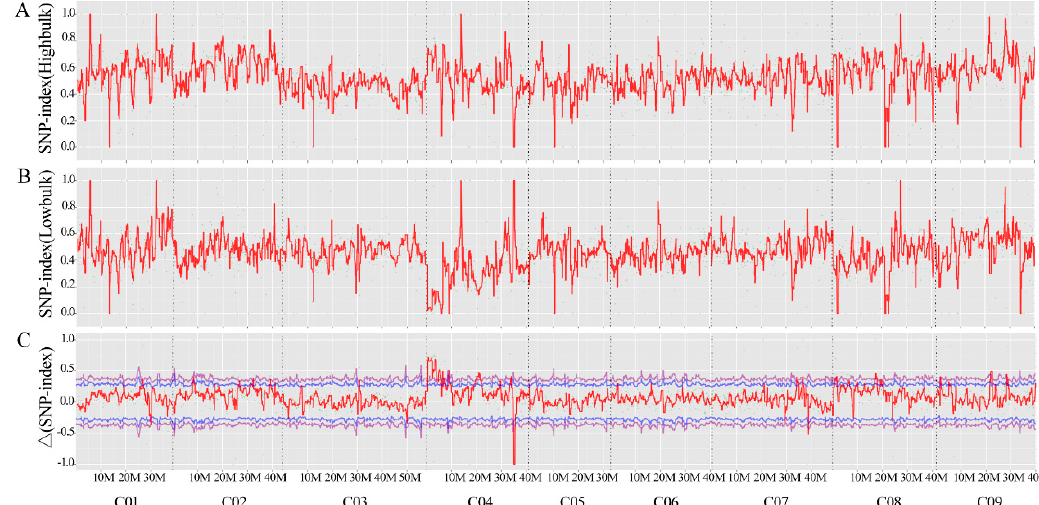
Figure 2. SNP-index graphs of bulk-R ( A ) and bulk-N ( B ), and ∆ (SNP-index) graph ( C ) based on BSA-seq analysis. The X-axis represents the position of genome and the Y-axis represents the SNP-index for A and B, and ∆ (SNP-index) for C. A candidate region was identified in chromosome C04 (3 to 7 Mb interval) with the peak position at 4.01 Mb.